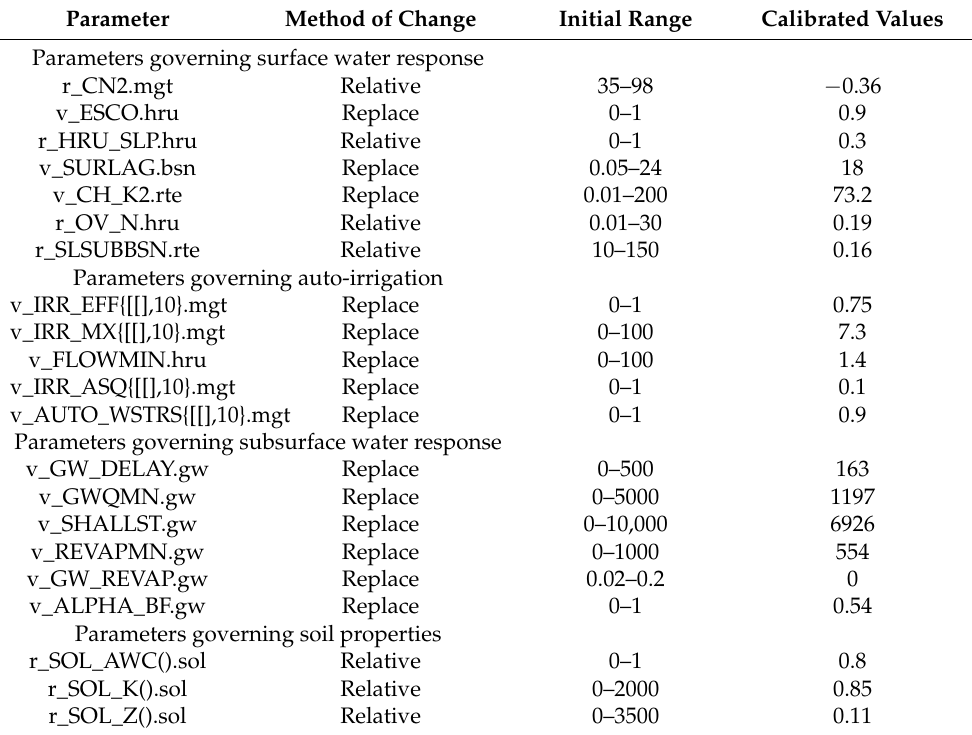
Table 5. Properties, method of change, initial range, and calibrated values for each parameter.